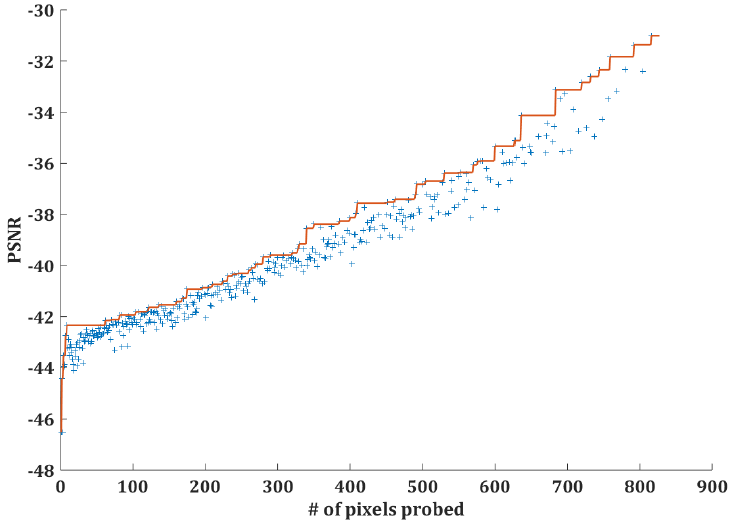
Figure 16. PSNR corresponding to different amounts of